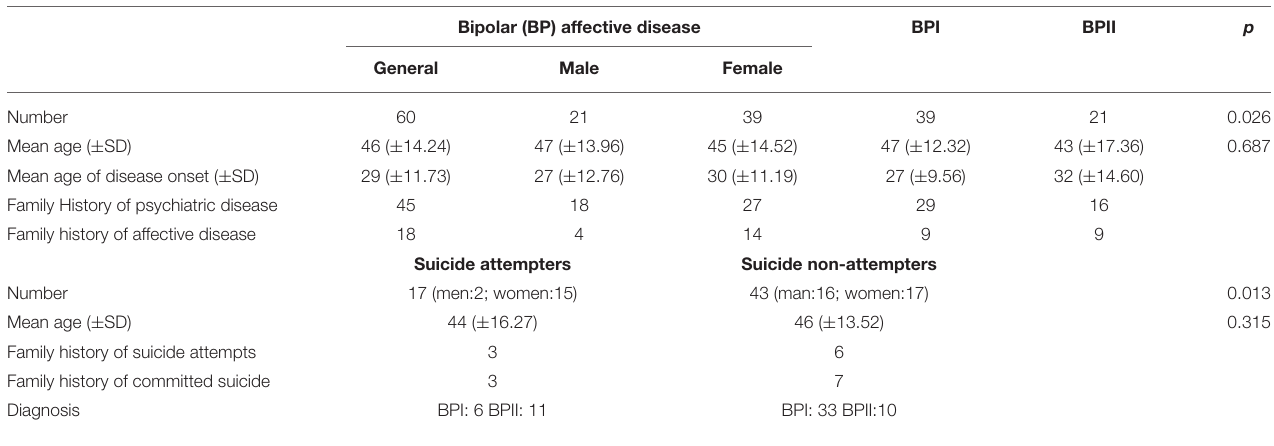
TABLE 1 | Demographic structure of studied